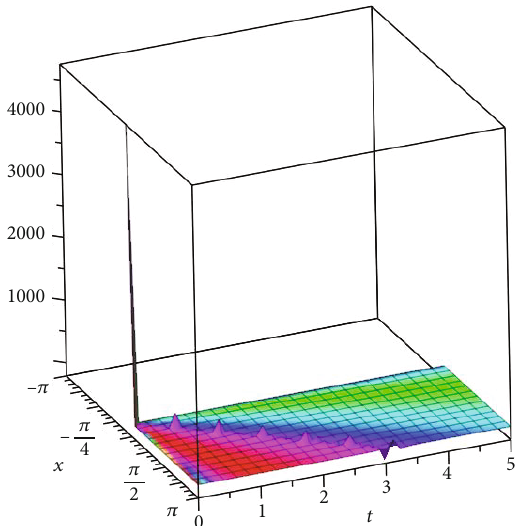
Figure 5: Graphical representation of solution u (23) for t = 0 :: 5, x = − π :: π , for α = 0 : 5